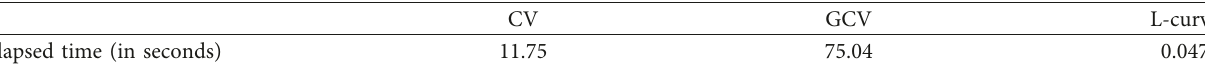
Table 6: The result of the comparison between cross validation (CV), generalized cross validation (GCV), and L-curve criterion in PLS regression in terms of speed of execution in the case of simulated datasets.